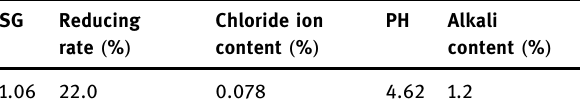
Table 4: HRWR properties